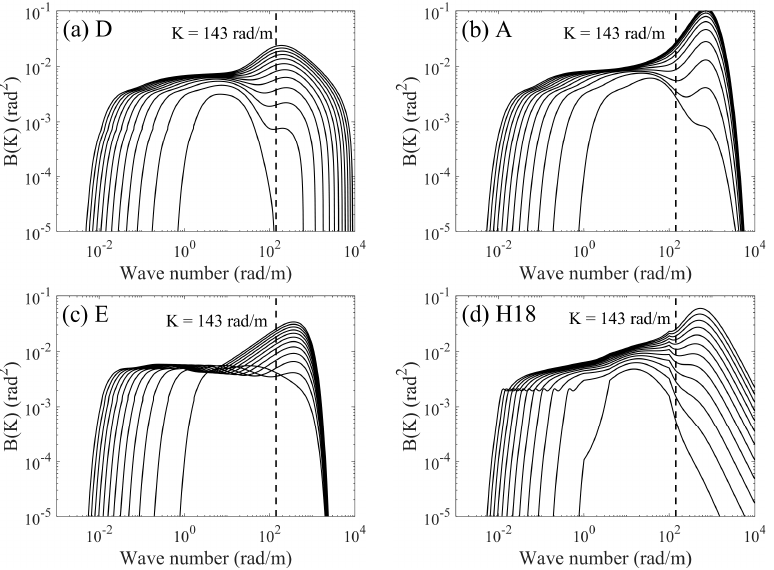
Figure 1. Curvature spectra B ( K ) in log − log scales: ( a ) the D spectrum, ( b ) the A spectrum, ( c ) the E spectrum, and ( d ) the H18 spectrum. Wind speed increases upward from 2 m/s to 24 m/s in 2 m/s steps.